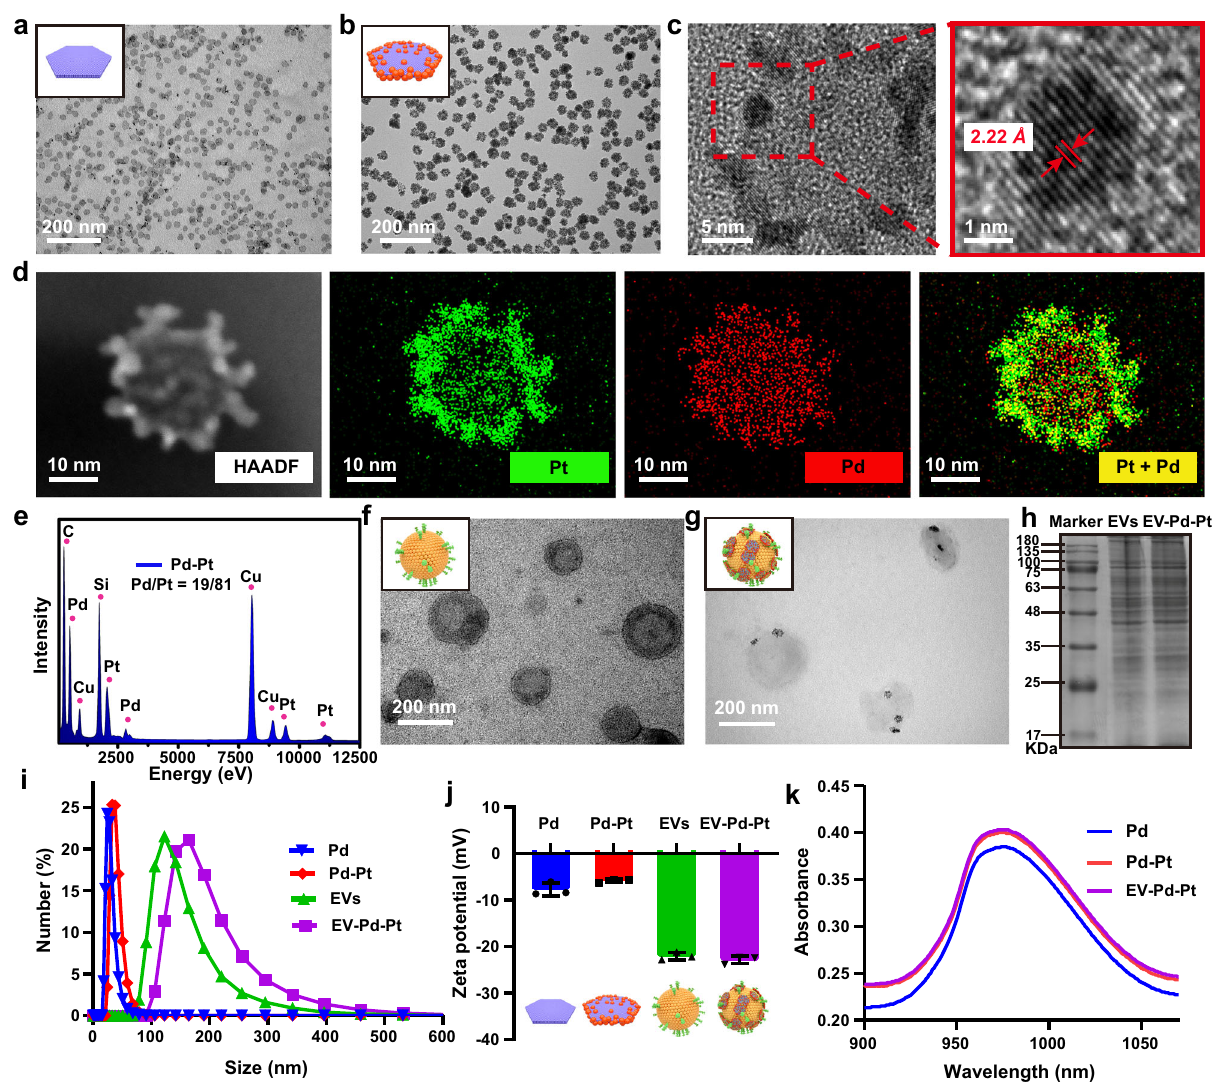
Fig.2|CharacterizationofEV-Pd-Ptnanoparticles. TEMimagesofPd( a )andPd- Pt( b )nanosheets. c Enlargedandhigh-resolutionTEMimagesofPd-Ptnanosheets. d Scanning TEM elemental mapping of Pd-Pt nanosheets. e EDS of Pd-Pt nanosh- eets.TEMimagesofEVsextractedfromthegingerjuice( f )andEV-Pd-Pt( g ). h SDS- PAGE protein analysisofEVs and EV-Pd-Pt. a , b , d , f – h , Experiments were repeated